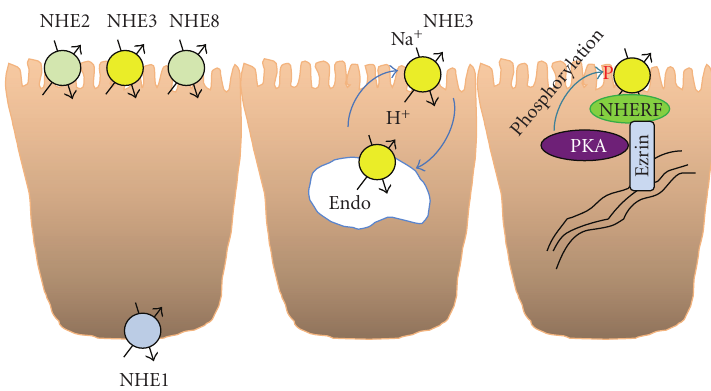
Figure 1: Regulation of NHE3 by multiple